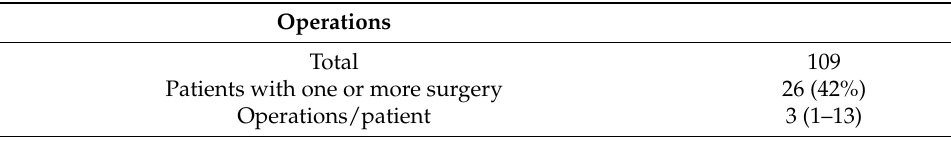
Table 5. Surgeries among 62 patients with spina